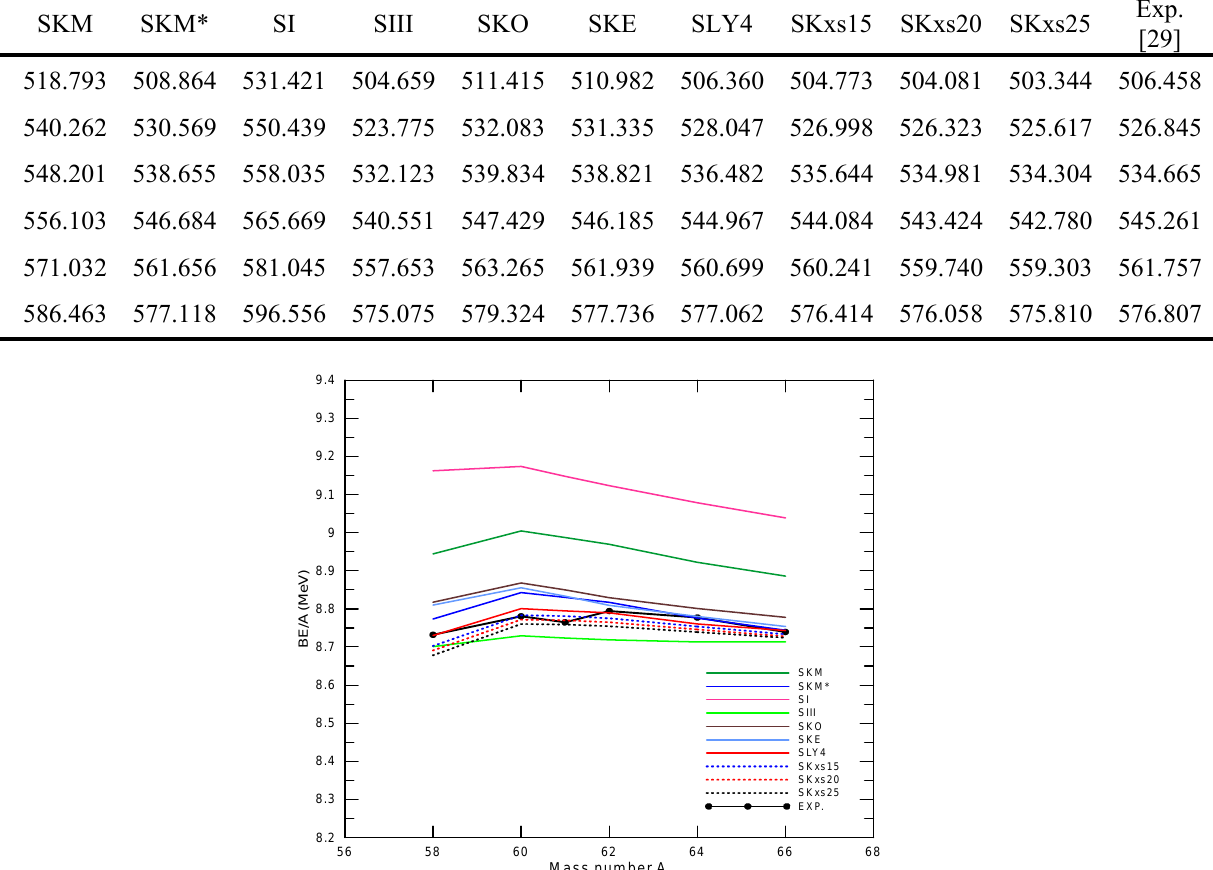
Fig.4: Calculated binding energies per nucleon for 58-66 Ni isotopes compared with experimental data taken form Ref.